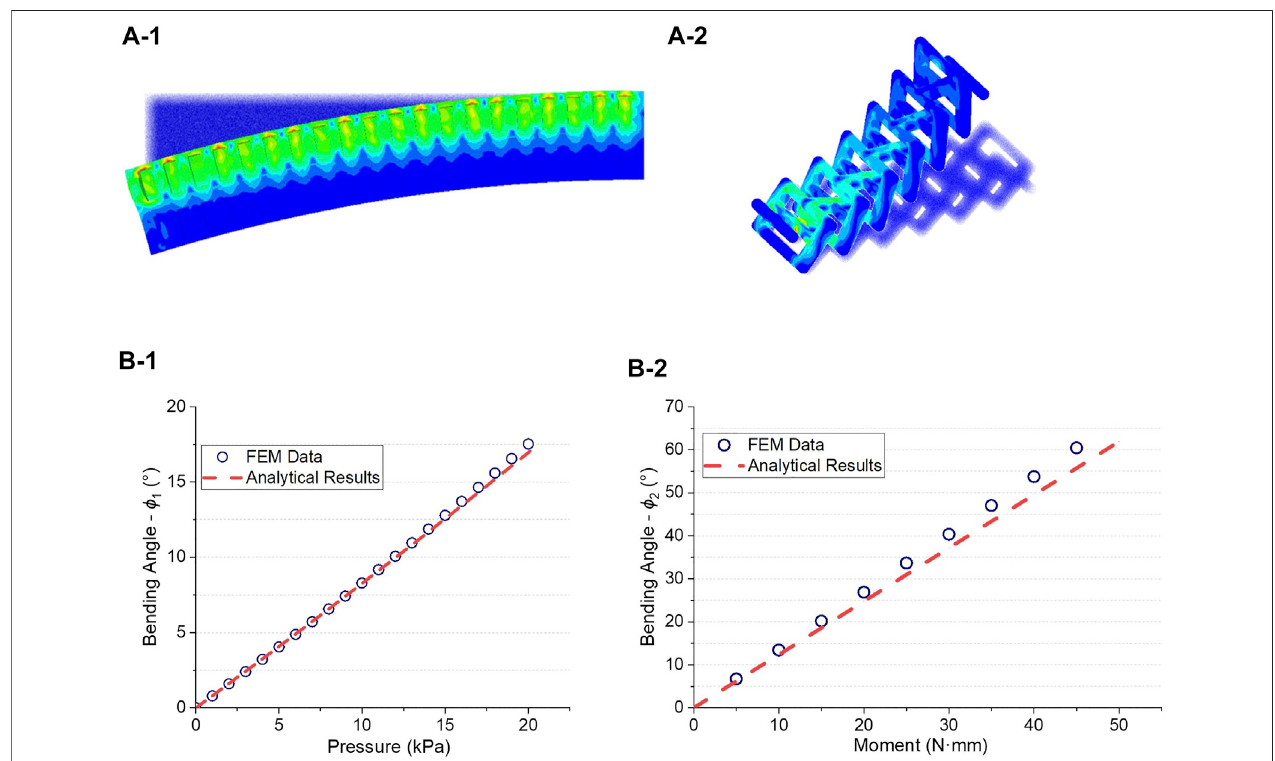
FIGURE5| AnalyticalmodelvalidationbyFEM. (A-1) FEMresultofadeformedpneumaticsparand (A-2) FEMresultofapantographicrib;Curvesofbendingangle respecting to external loads along (B-1) spanwise and (B-2) chordwise (Broken red line: analytical model, blue circles: numerical results).